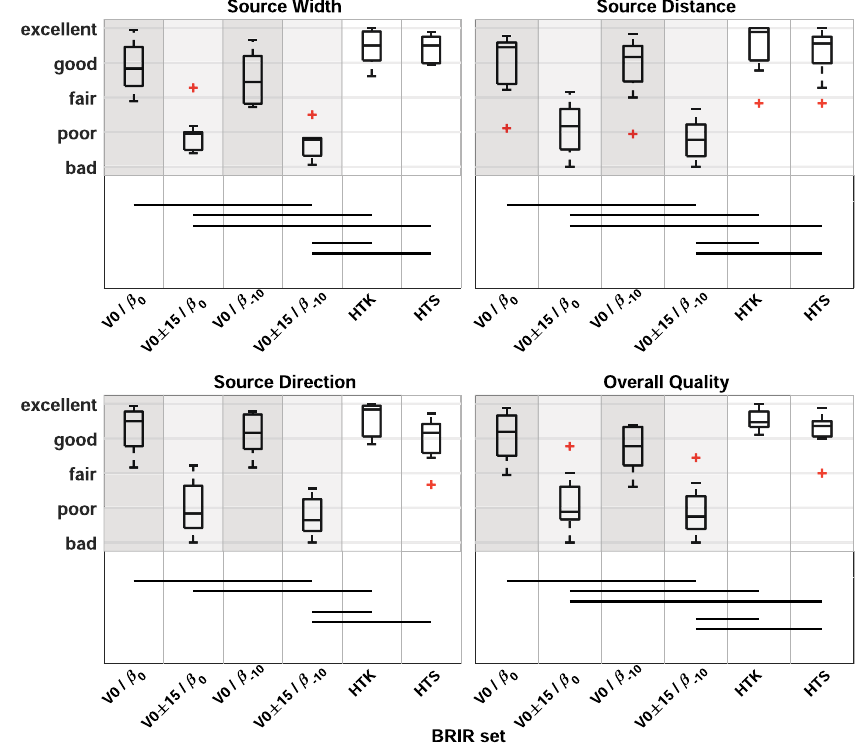
Figure 10. (Experiment 2) Averaged ratings over three source positions for different BRIR sets and perceptual attributes. Signi fi cant different ratings are marked with horizontal lines ( p <